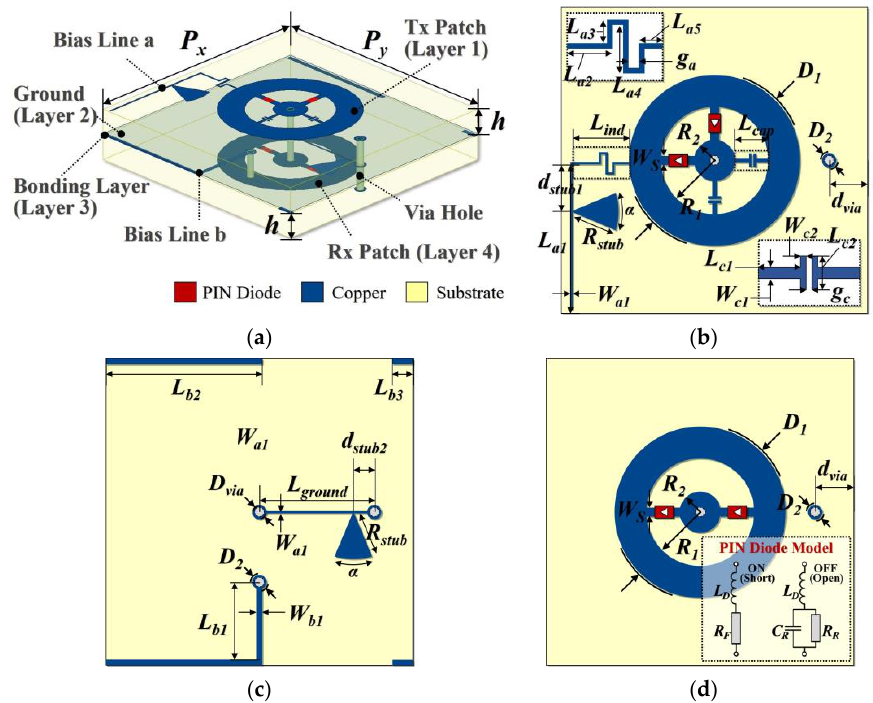
Figure 3. Geometry of proposed unit-cell to implement multi-function: ( a ) Perspective view; ( b ) Tx patch (layer 1); ( c ) Bias line (layer 3, layer 2 is ground plane); ( d ) Rx patch (layer 4).